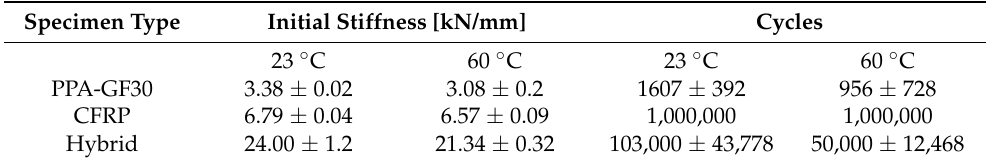
Table 3. Comparative analysis at the two different testing temperatures. The stop criterium is 1,000,000 cycles.